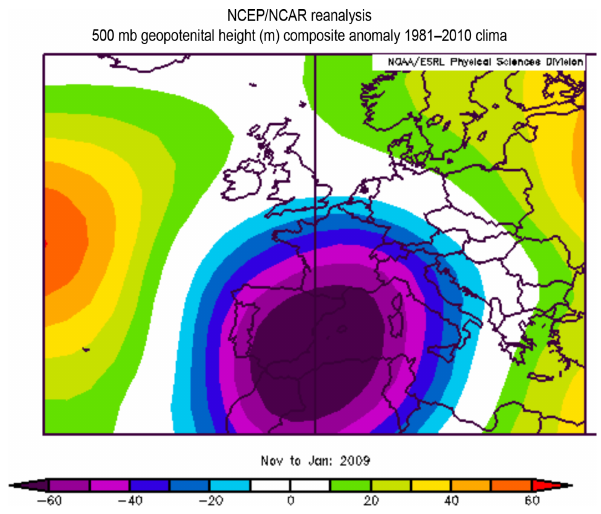
Figure 14. Geopotential height anomalies at 500hPa for November 2008–January 2009 with respect to the reference period 1981–2010 (source NCEP/NOAA